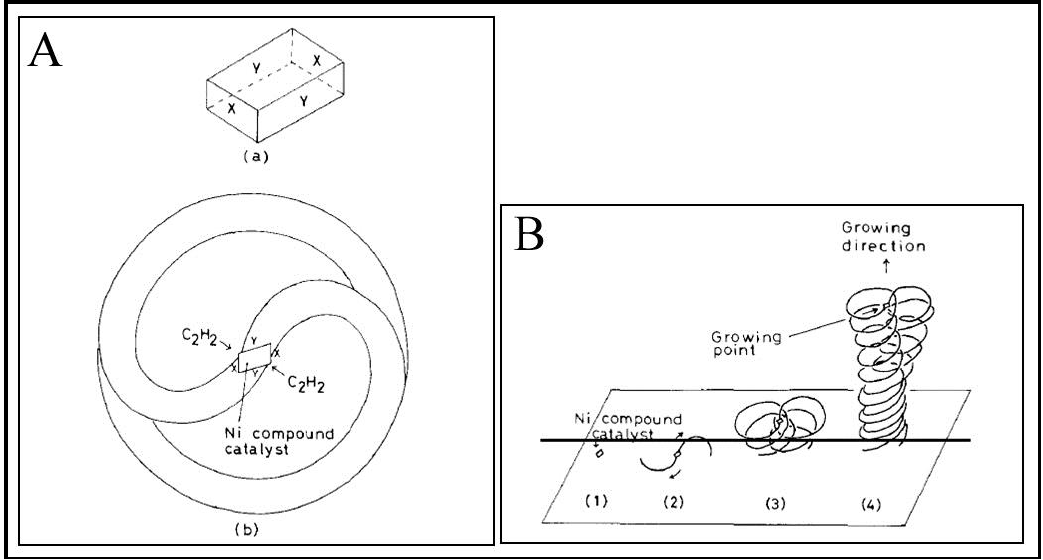
Figure 9. ( A ) Simplified scheme for the growth mechanism of HCF: ( a ) Ni compound seed (single crystal) on tip part of pair-HCF, ( b ) growth mechanism of pair-HCF; and ( B ) growth process of pair-HCF ([113], Kawaguchi et al ., 1992).